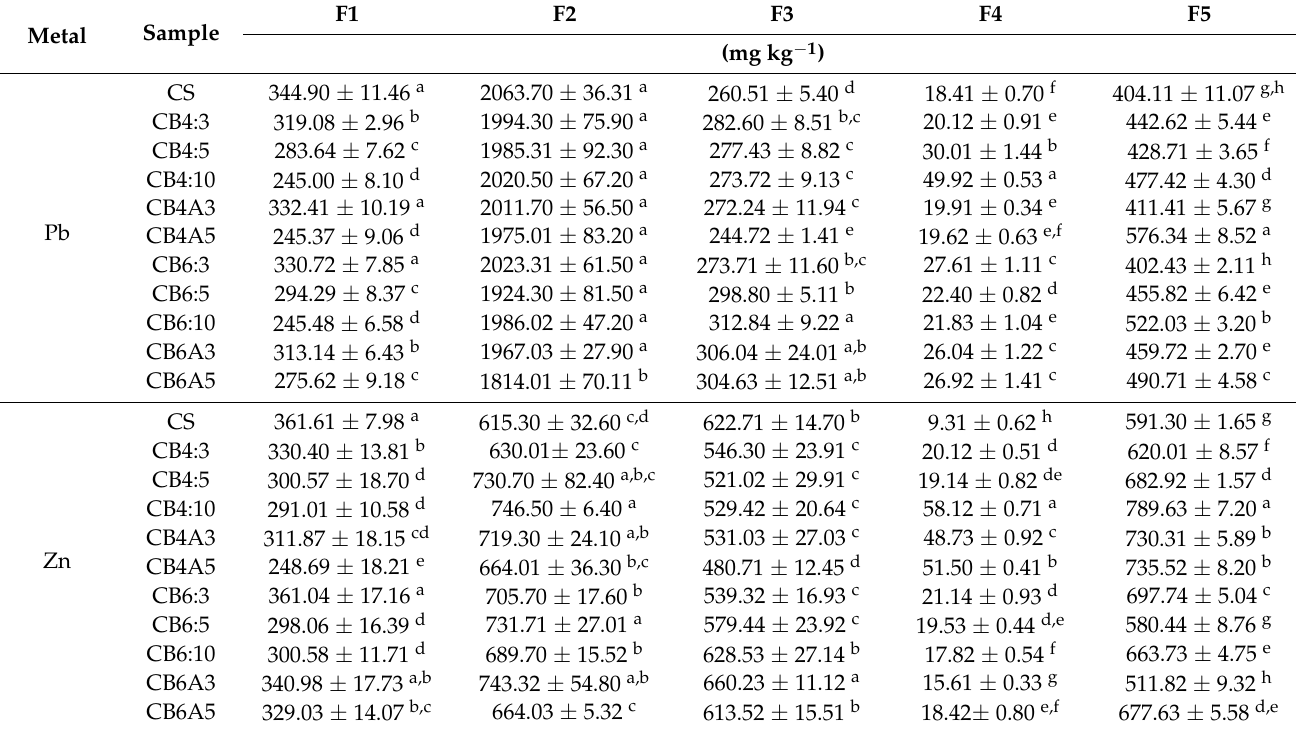
Table 3. Chemical fractions of Pb and Zn in the soil incubated with biochar and apatite after 30